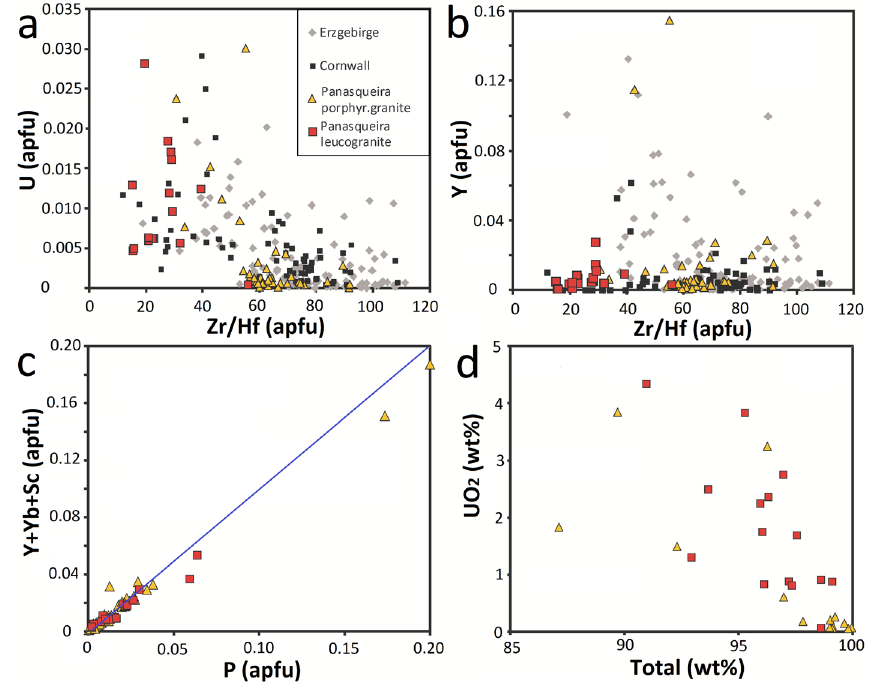
Figure 13. Chemical composition of zircon: ( a ) Zr/Hf vs. U; ( b ) Zr/Hf vs. Y; ( c ) P vs. Y; ( d ) total vs. UO 2 . For comparison, data of zircons from peraluminous rare-metal granites from the Erzgebirge [42] and Cornwall [43] are shown in Figures ( a ) and ( b ) .